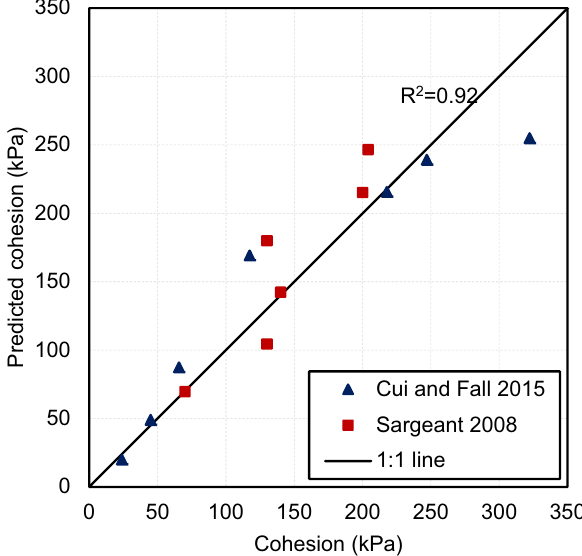
Fig. 2 Experimental versus predicted values of cohesion. Fig. 3 Experimental versus predicted values of internal